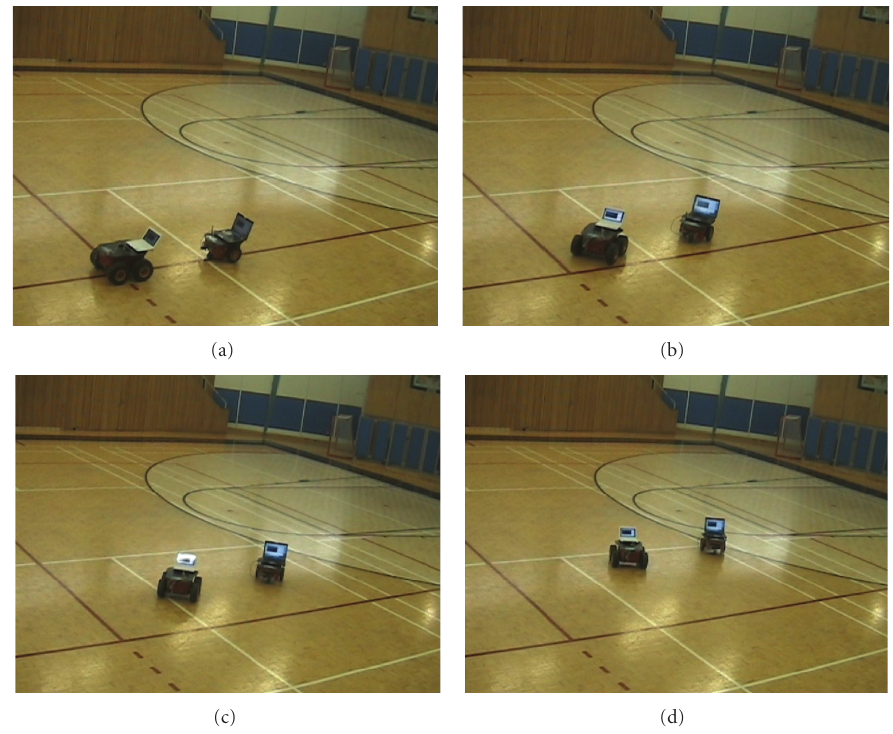
Figure 12: Experimental result of group movement tracking curve: (a) 0 second; (b) 7 seconds; (c) 20 seconds; (d) 35 seconds.